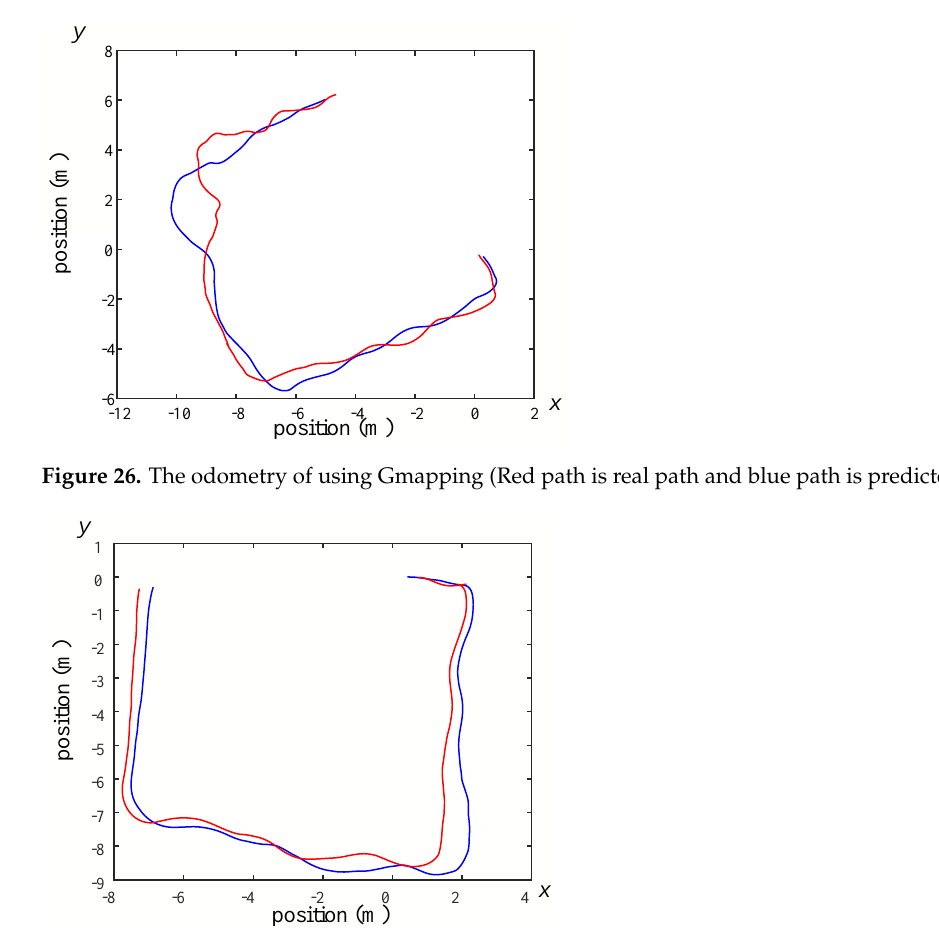
Figure 27. The odometry of using Hector (Red path is real path and blue path is predicted path).